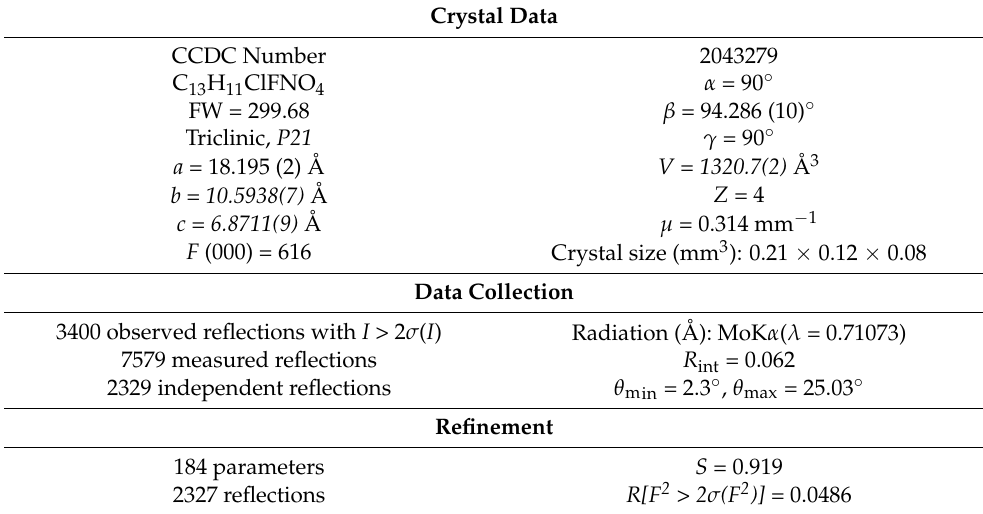
Table 1. Crystal data of title compound 6c